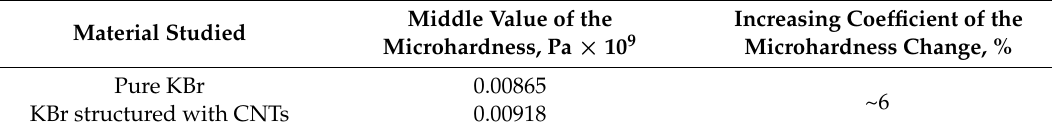
Table 1. Comparative data of the KBr microhardness change (Indentor was 10 g).